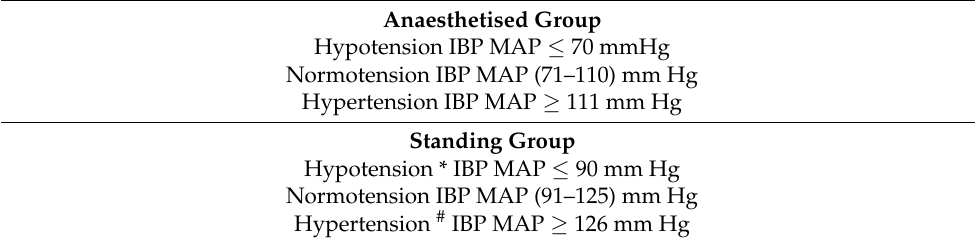
Table 1. Arterial blood pressure state